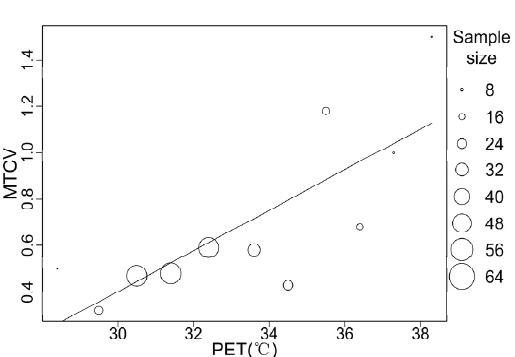
Figure 5. Correlation between MTCV and PET of the elderly in summer.